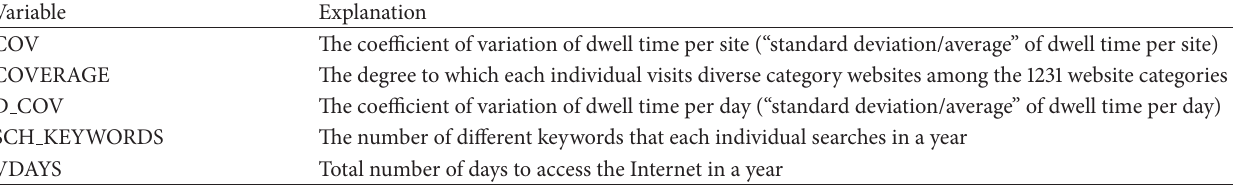
Table 2: Segmentation variables for behavior characteristics.